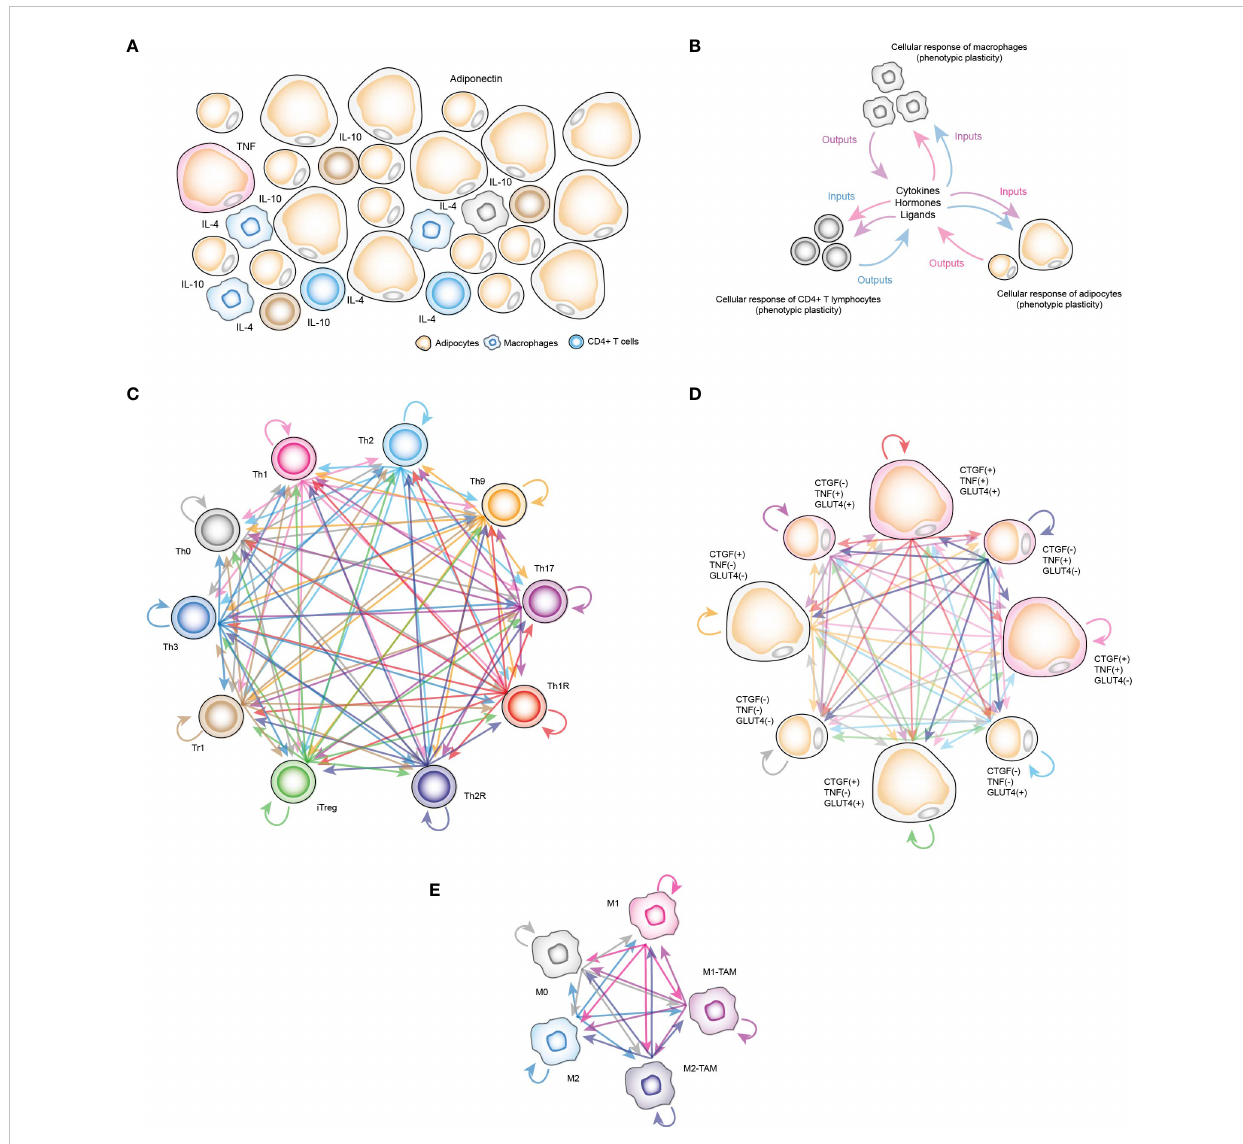
FIGURE 1 Computational stochastic models to represent the VAT. (A) Schematic representation of the VAT with adipocytes, resident macrophages and CD4+ T lymphocytes. (B) Schematic representation of functioning VAT model. (C) Stochastic model of all phenotypes of CD4+ T cells considered in this work. Each arrow represents a stochastic transition between each phenotype, and the probability of transition between states is determined by the microenvironment signals present in the VAT. (D) Stochastic model of phenotypes of adipocytes. Each phenotype represents determined metabolic and genetic state of these cells in response to insulin, and other chemical components of VAT. (E) Stochastic model of macrophage